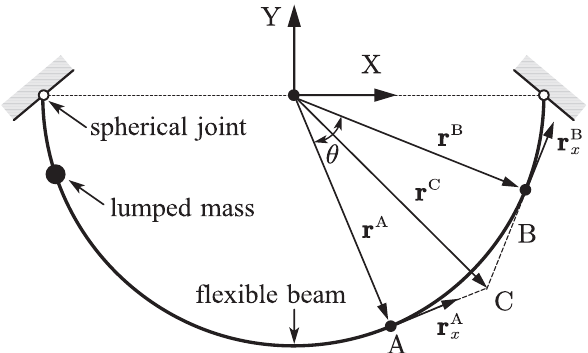
Figure 15. Initial configuration of numerical example 3.